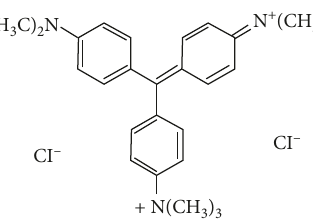
Figure 1: Structure of the molecule of methyl